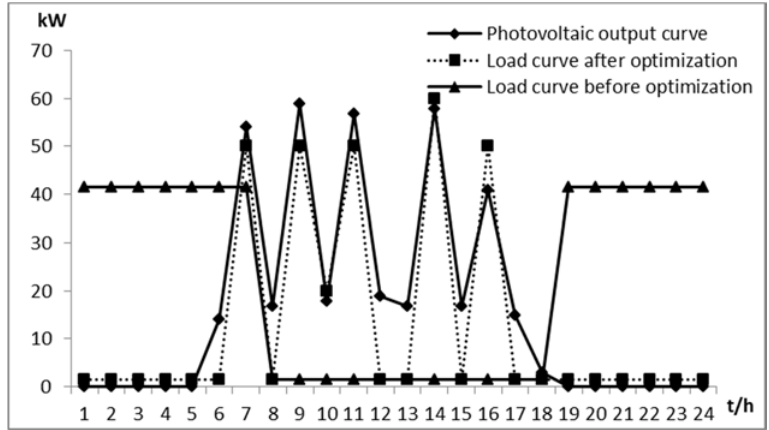
Figure 7. Comparison curve of load before and after optimization on a rainy winter day.